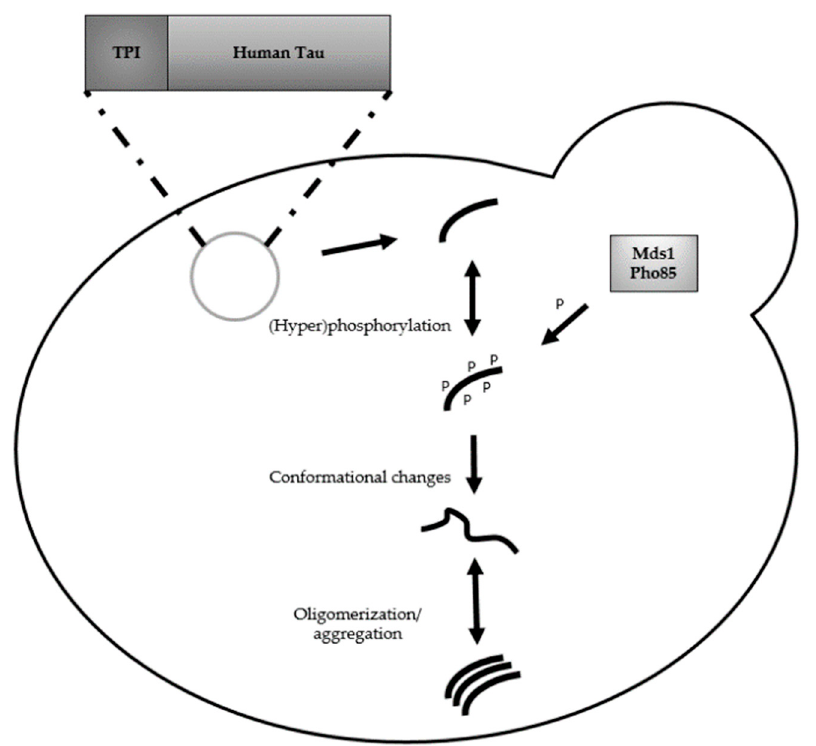
Figure 1. Humanized yeast model expressing human protein Tau: overview of Tau processes and modifications in S. cerevisiae. Double arrows indicate a bidirectional/reversible reaction and dashed lines specify the promoter and expressed human Tau gene on the plasmid. ‘TPI’; Triosephosphate isomerase promoter, ‘P’; phosphate group.